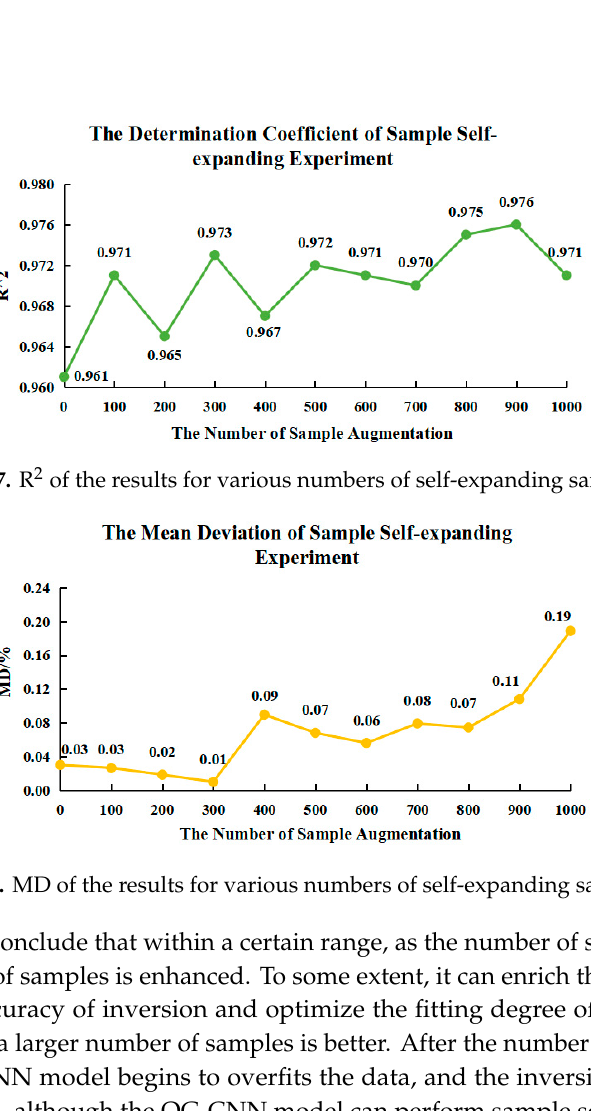
Figure 6. MRA of the results for various numbers of self-expanding samples.